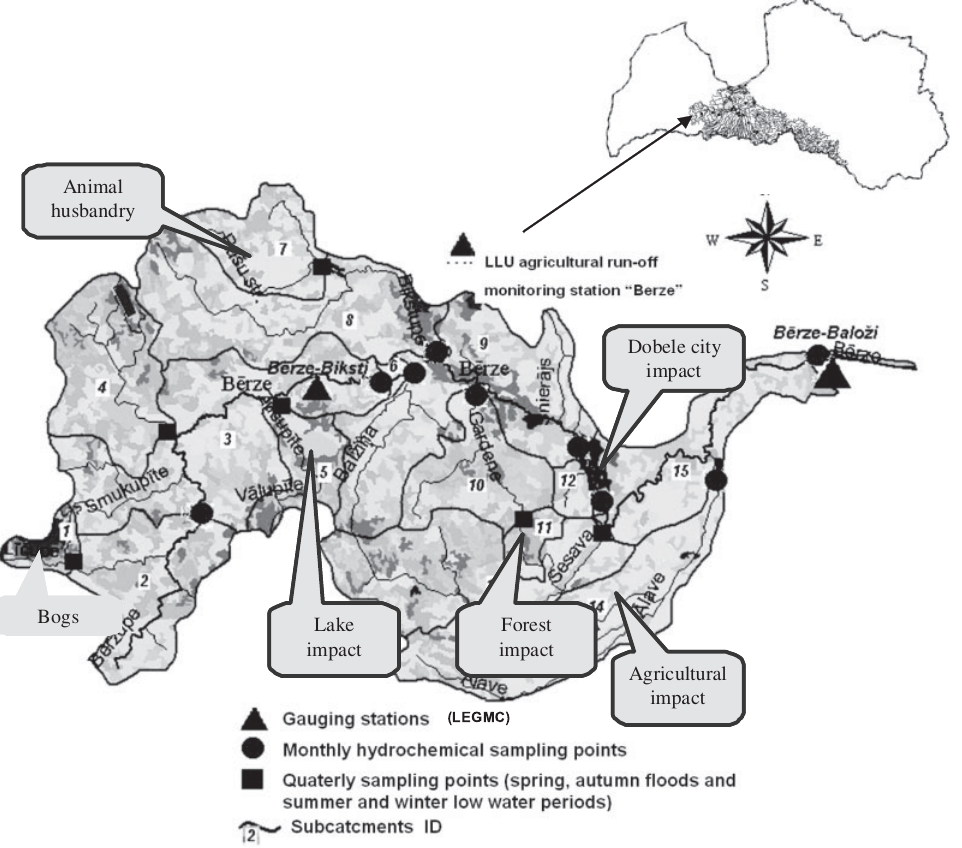
Fig. 1. Location of Be¯rze River and water quality monitoring